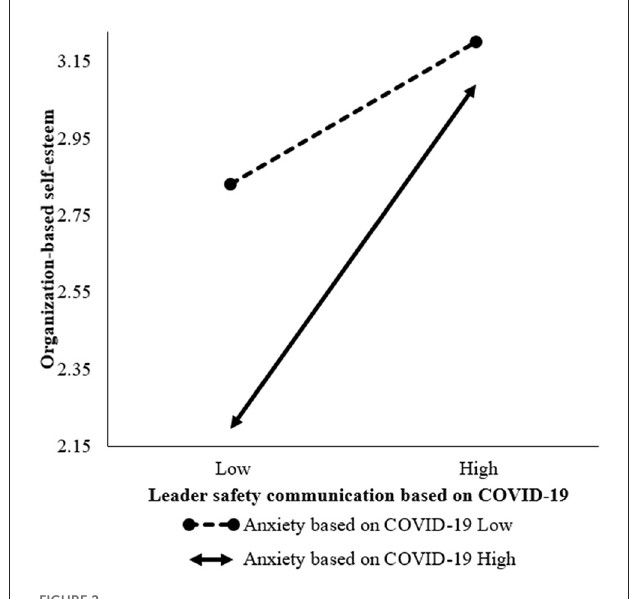
FIGURE2 Interaction effect of leader safety communication based on COVID-19 and anxiety based on COVID-19 on OBSE.